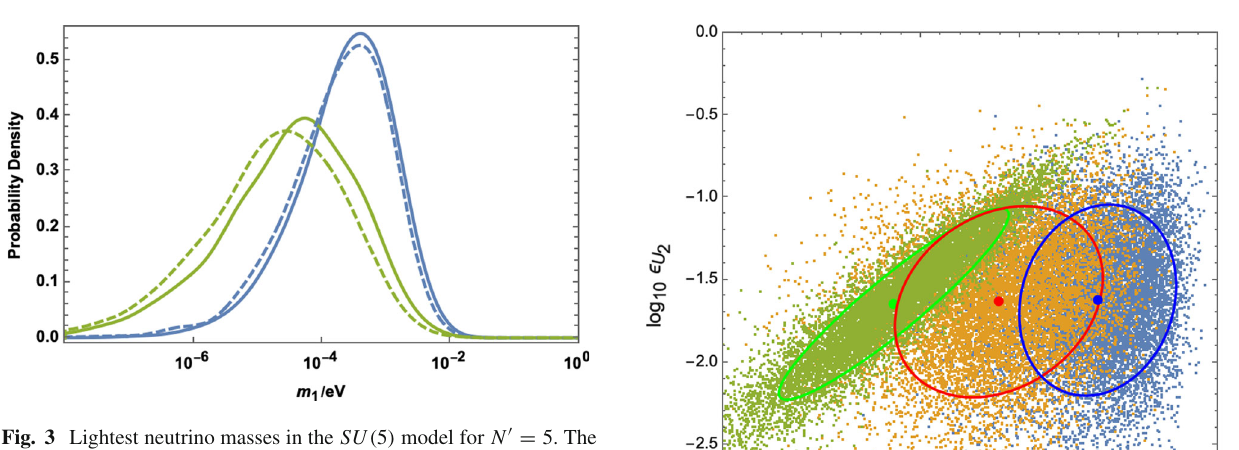
Fig. 3 Lightest neutrino masses in the SU ( 5 ) model for N (cid:4) = 5. The curves correspond to N = 1 (blue) and N = 3 (green), as well as tan β = 40 (solid) and tan β = 10 (dashed)